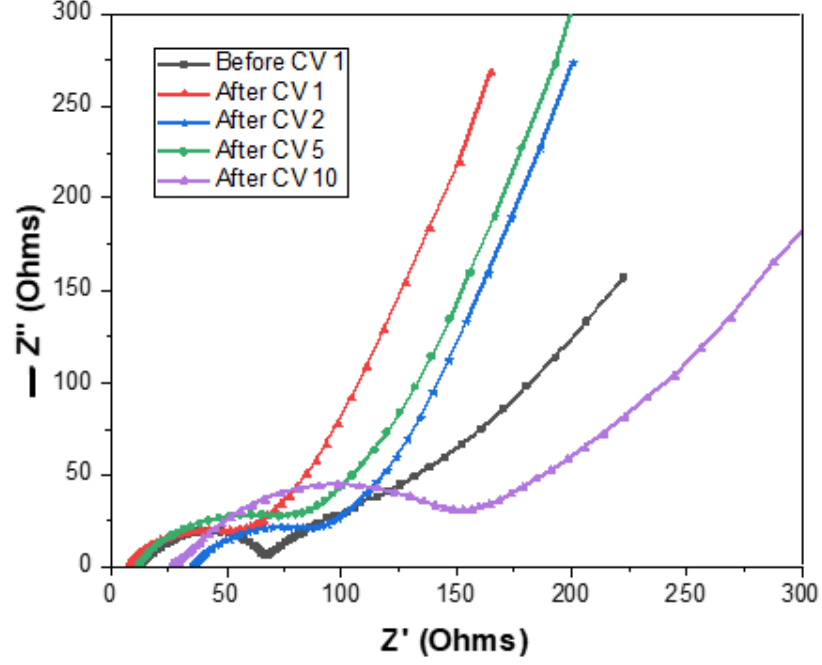
Figure 9. EIS Nyquist plot of Si 3 N 4 @Si@Cu anode in half-cell using Li metal as counter and reference electrodes.